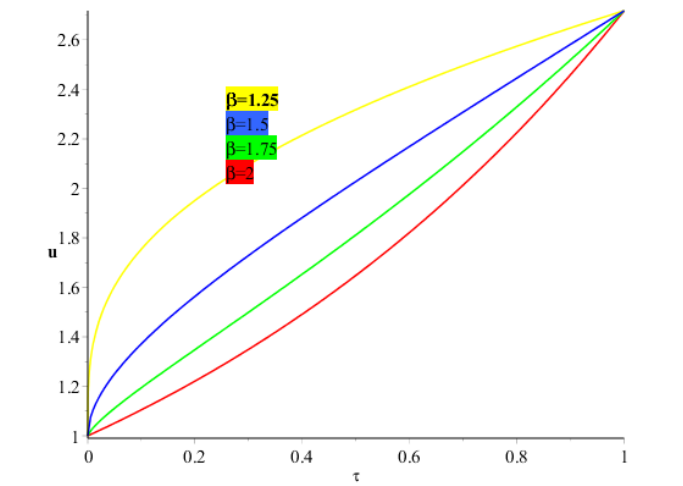
Figure 4. Represents the solution at different fractional order of Example 1.